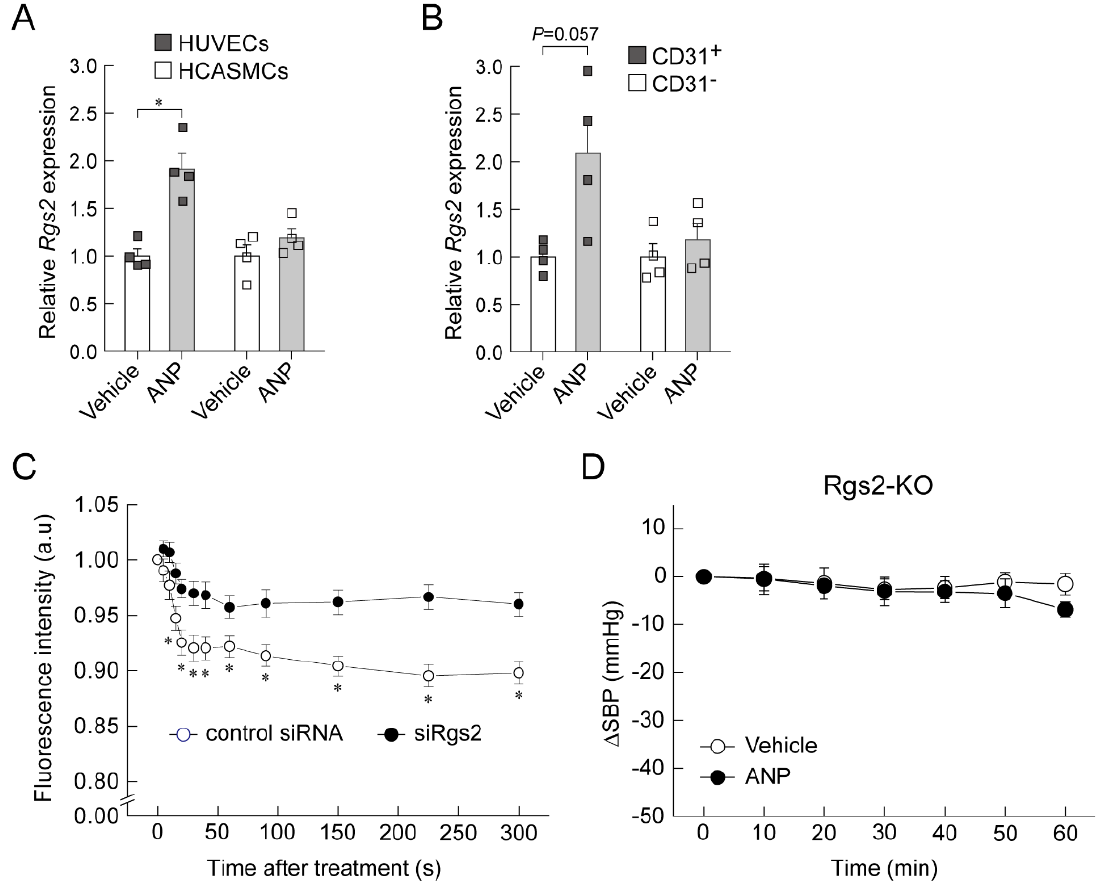
Figure 6. RGS2 plays a key role in the hypotensive effect of ANP infusion. ( A ) ANP increased Rgs2 mRNA expression in human umbilical vein endothelial cells (HUVECs) but not in human coronary artery smooth muscle cells (HCASMCs). HUVECs and HCASMCs were treated with vehicle (PBS) or ANP for 60 min. mRNA levels were normalized to those of GAPDH. Values are expressed relative to vehicle ‐ treated cells. * p < 0.05. ( B ) ANP increased Rgs2 mRNA expression in CD31 + cells but not in CD31 − cells. After 48 h of continuous administration of vehicle (saline) or ANP (0.2 μ g/kg/min), the Rgs2 mRNA levels were evaluated in CD31 + cells and CD31 − cells. ( C ) RGS2 plays a key role in ANP ‐ mediated hyperpolarization in HUVECs. Changes in the membrane potential in HUVECs transfected with control siRNA or Rgs2 siRNA (siRgs2) were evaluated. DiBAC4(3) ‐ loaded HU ‐ VECs were treated with ANP. Values are expressed relative to the intensity of the control siRNA ‐ transfected cells at time 0. * p < 0.05 vs. siRgs2. ( D ) ANP infusion failed to decrease systolic blood pressure (SBP) in RGS2 knockout (Rgs2 ‐ KO) mice. Intravenous infusion of ANP (10 μ g/kg/min) did not significantly lower SBP compared with the vehicle infusion. This figure is a reconstruction of the figure in our original article [37].